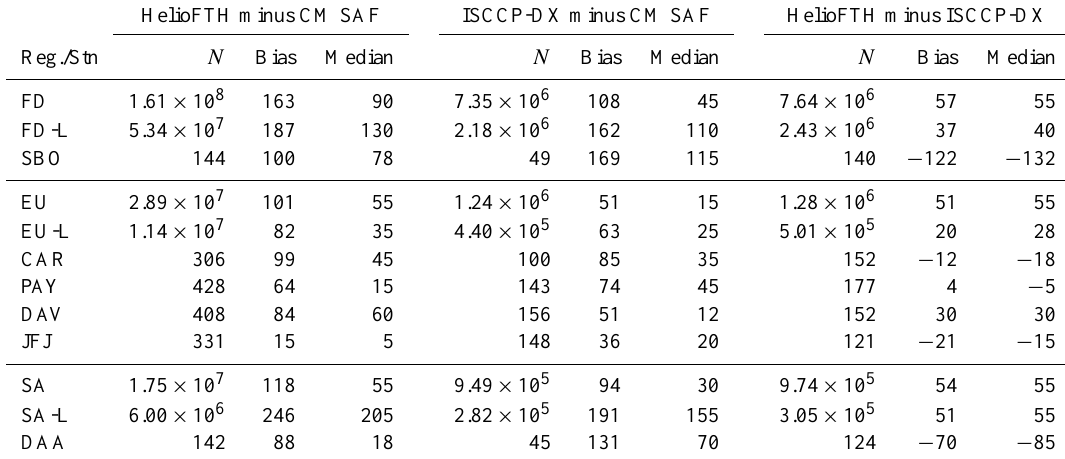
Table 4. Bias=mean(satellite − satellite) and median=median (satellite − satellite) of CTP product inter-comparison given in hectopascal (hPa) for full disk (FD), Europe (EU), South Africa (SA) and for all sites with synop observations from Table 1 for April 2004. Suffix “L” indicates pixels over land only, and N the number of compared values. HelioFTH minus CM SAF ISCCP-DX minus CM SAF HelioFTH minus ISCCP-DX Reg./Stn N